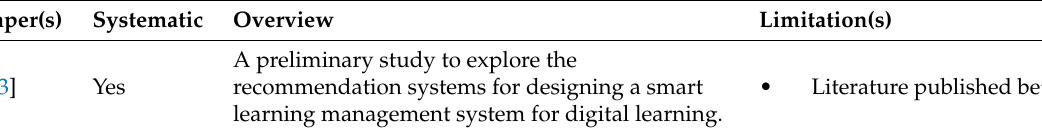
Table 1. Literature review